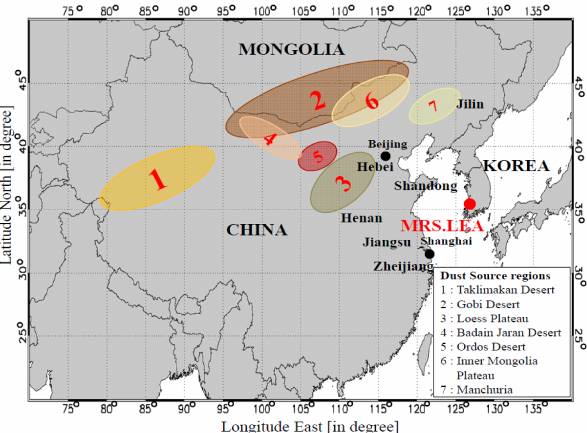
Figure 1. Map of the desert regions (Taklimakan, Gobi, Badain Jaran, Ordos, Inner Mongolia plateau, and Manchuria) and loess regions (Loess Plateau and Manchuria). The location of some ma- jor cities (Beijing and Shanghai) and industrialized areas of China (Hebei, Shandong, Henan, and Zhejiang province) is also